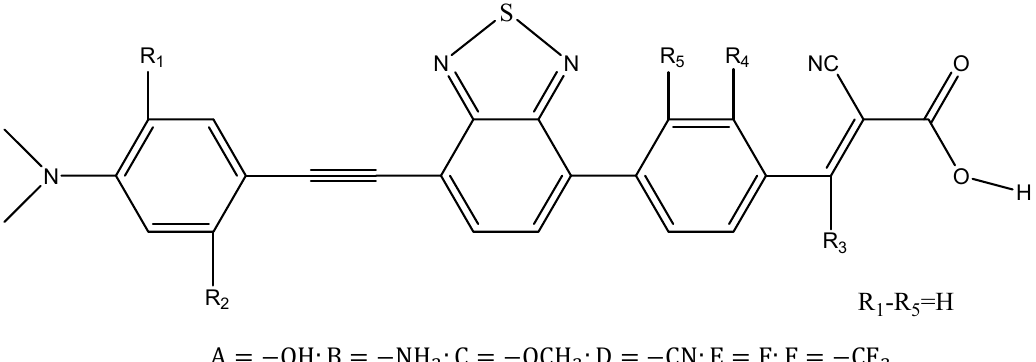
Figure 8. Molecular structures of dye LS-387 and designed molecules (LS-387-X and LS-387-Y). The molecules (LS-387-X and LS-387-Y) ground state were optimized in DMF solvent, and bond length and dihedral angle are listed in Tables S4 and S5. As shown in Table S4, the bond length ( 𝑑 (cid:2869) to 𝑑 (cid:2874) ) of LS-387-1A (1B and 1C) is not obviously changed compared with LS-387; However, the 𝑑 (cid:2869)